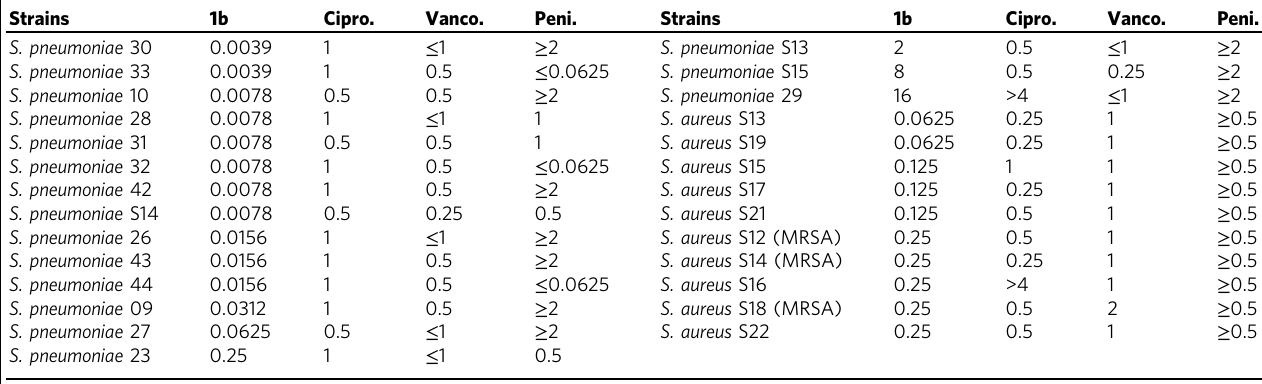
Table 2 MIC values ( µ g/mL) of albomycin δ 2 (1b) against clinical isolates of S. pneumoniae and S. aureus